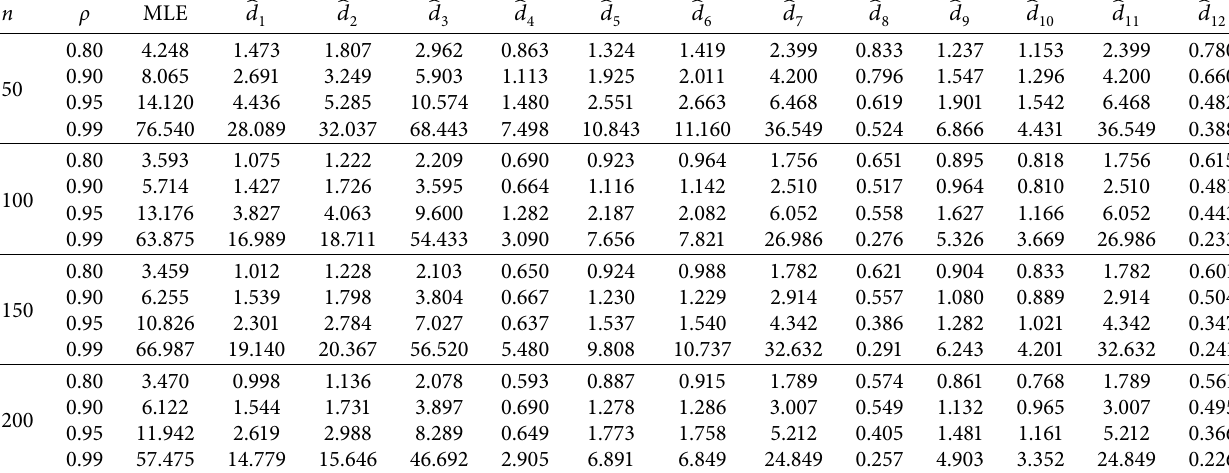
Table 3: Estimated MSEs of the COMPRM estimators, when p � 3 and ϑ � 1 .